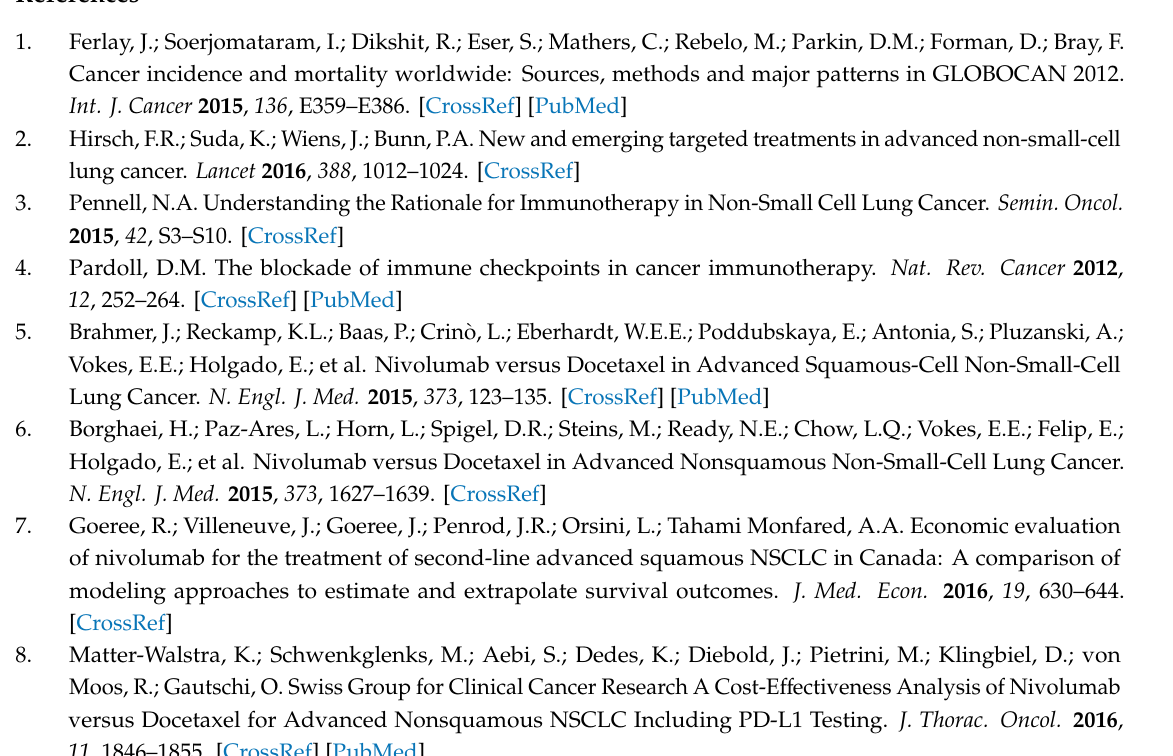
Figure S1: Unsupervised hierarchical clustering of basal kinase activity profiles among non-small-cell lung cancer patients PBMC ( n = 28) and healthy volunteers ( n = 12), Table S1: QC list of the 80 peptides substrates of serine / threonine kinases presenting nominal CV lower than 50%, Table S2: QC list peptides ( n = 80) ranking within the di ff erent clusters obtained after unsupervised hierarchical clustering of the kinase activity profiles. Peptides ordering is related to Figures 1 and 3, Table S3: Di ff erences in peptides phosphorylation ( n = 80) before and after nivolumab treatment, determined by a Student’s paired t